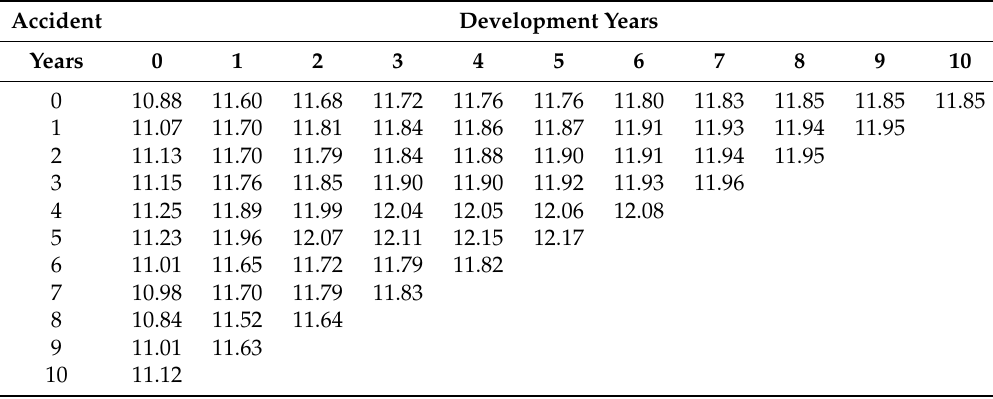
Table A2. Parameter µ of the log-normal distributions used to simulate